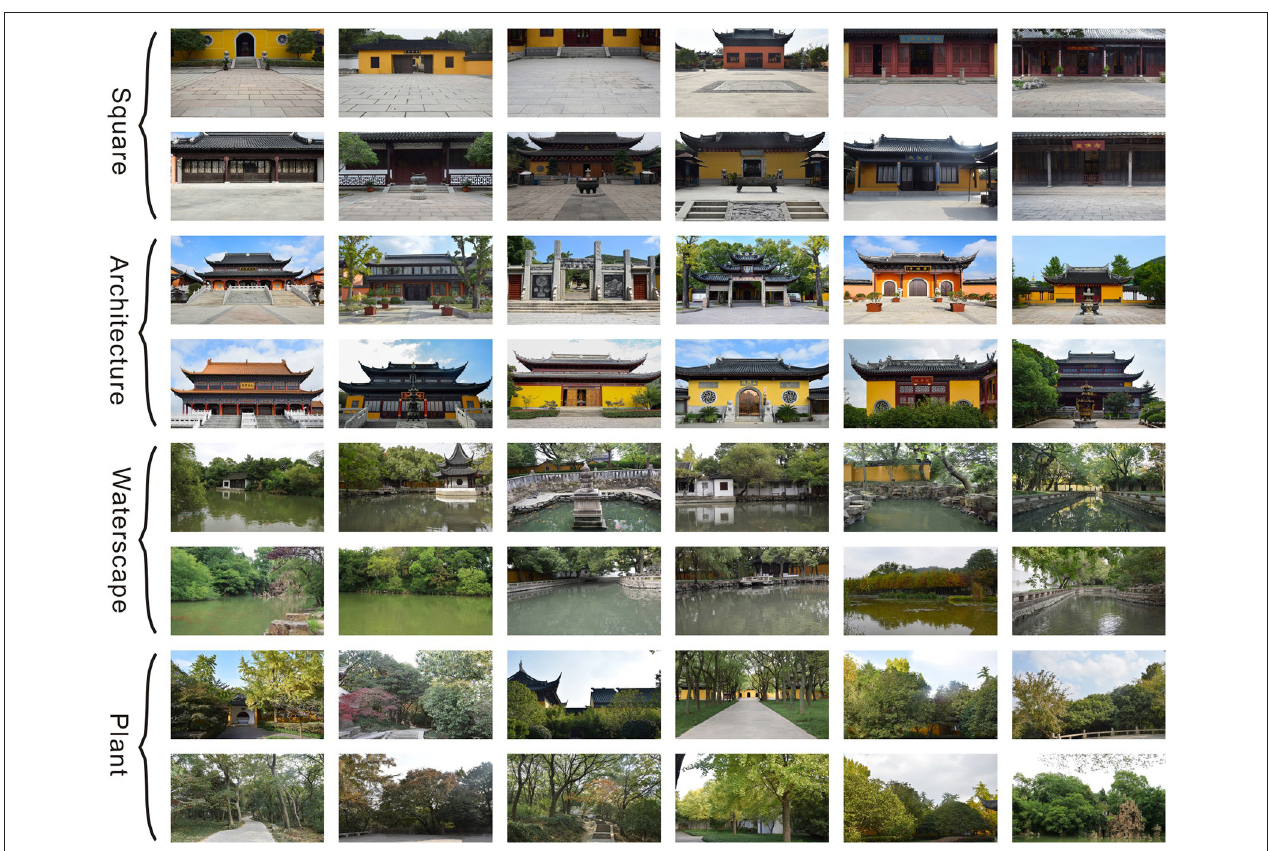
FIGURE 2 | The stimuli